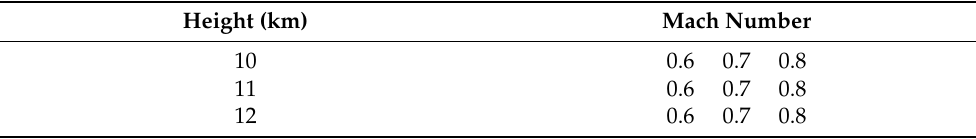
Figure 2. ICE aircraft flight envelope and nominal path: Map the flight trajectory to the height-mach profile so that we can select the design point. Table 1. Calculation status points in the launching separation stage.